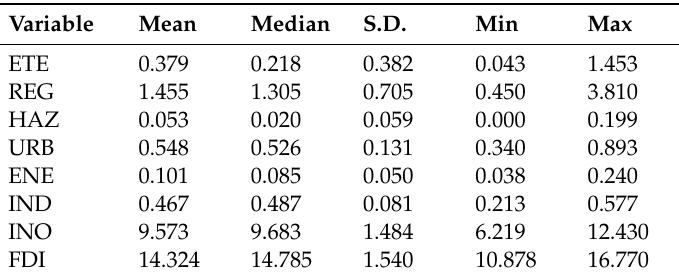
Table 1. Descriptive statistics of